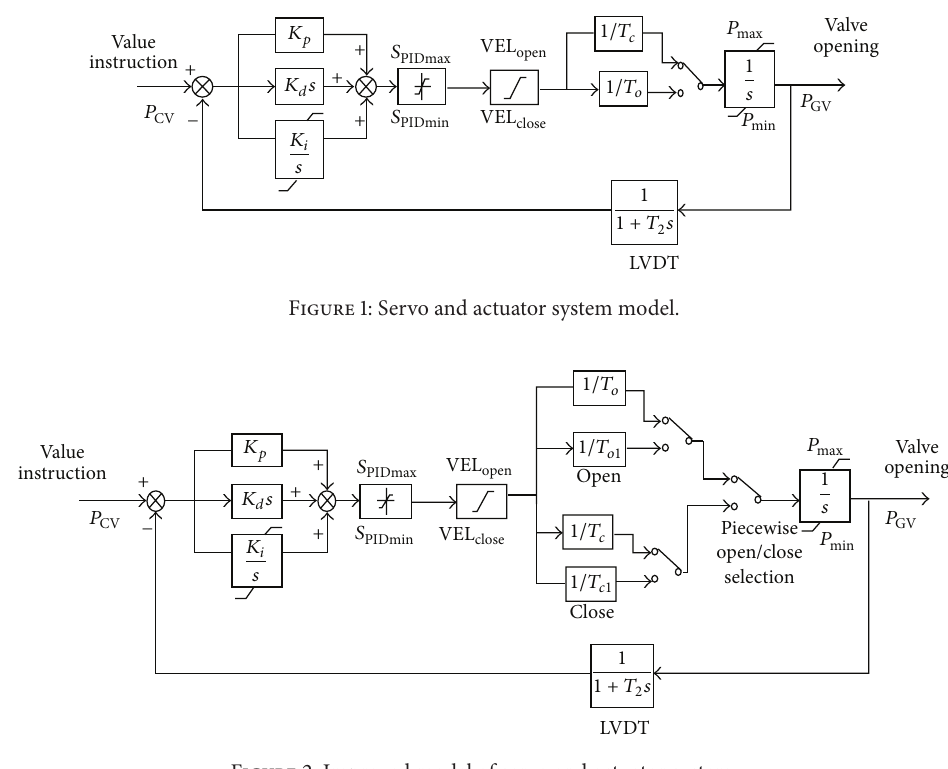
Figure 2: Improved model of servo and actuator